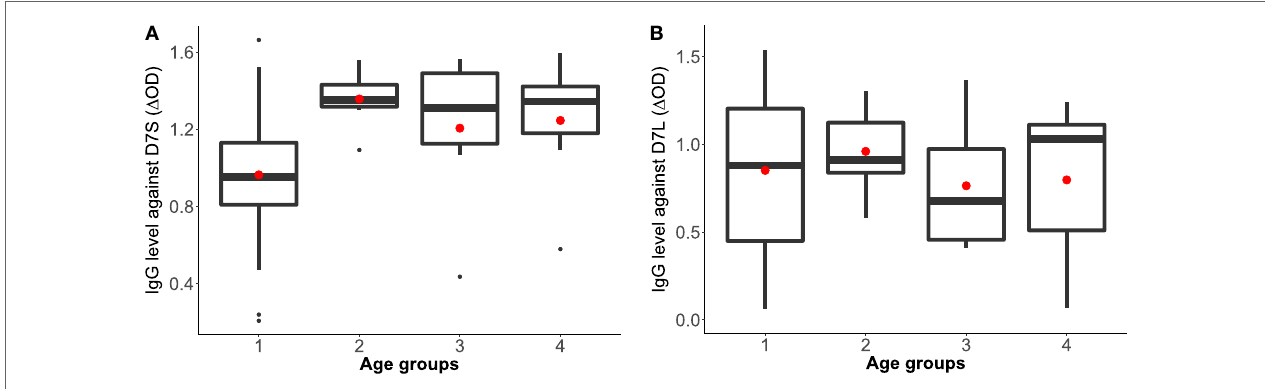
FigUre 2 | Aedes aegypti D7 short (a) and D7 long (B) salivary proteins and IgG antibody levels represented by age groups. Group 1: ages 1–19 years old ( n = 41), group 2: ages 20–39 years old ( n = 7), group 3: ages 40–59 years old ( n = 6); and group 4: individuals older than 60 years ( n = 7). The red dot indicates the mean and the bars show the first and third quartiles with median as the